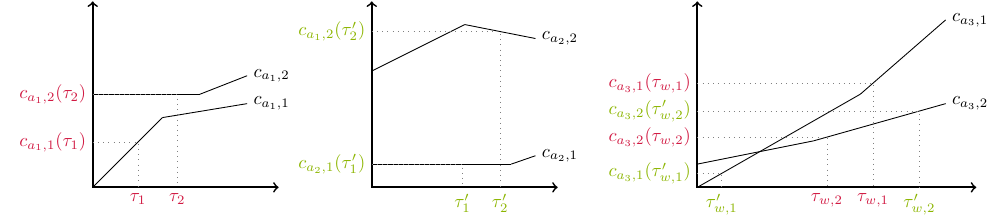
Figure 2. These plots show the two arc cost functions corresponding to the three arcs of the graph in Figure 1: the leftmost functions correspond to the arc a 1 = ( u , w ) ; the functions in the middle to the arc a 2 = ( v , w ) ; the rightmost functions to the arc a 3 = ( w , x )